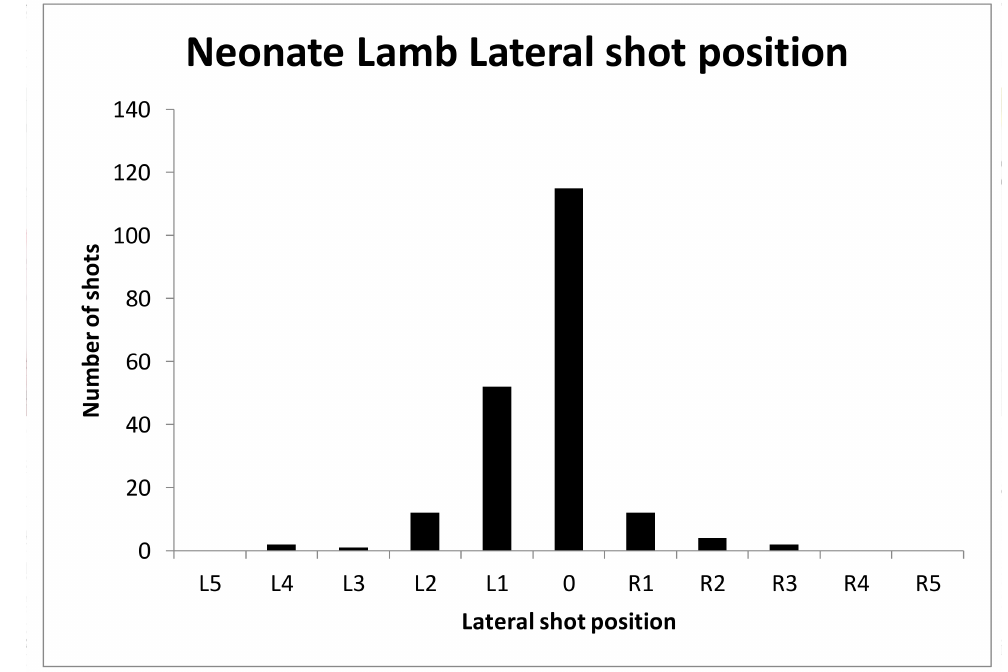
Figure 9. Graph of lateral shot position over the 200 lambs subjectively scored based on the lateral targeting position indicator in Figure 2 with 0 being on the midline, L1 being 0.5 cm to the left of this line, L2 1 cm to the left of the midline etc. and the codes R being to the right of the midline viewing the head from a caudal